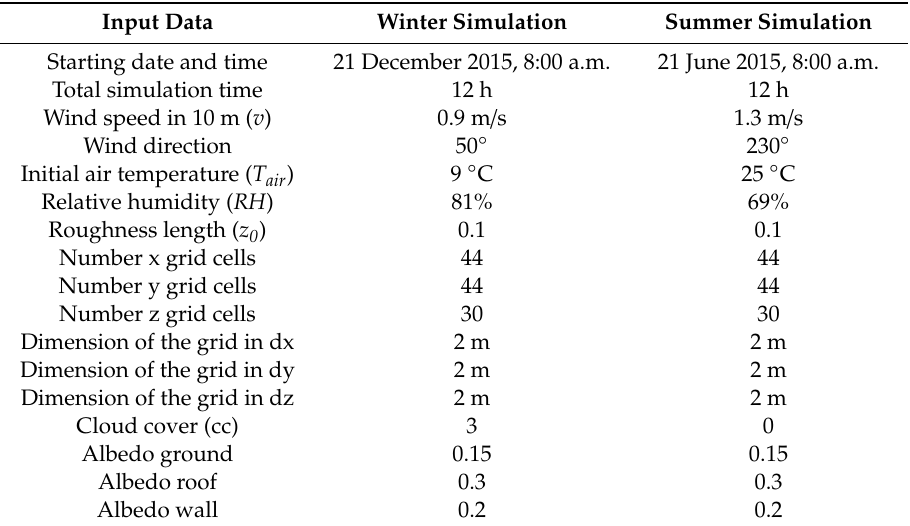
Table 1. Initial settings for winter and summer simulation used in ENVI-met